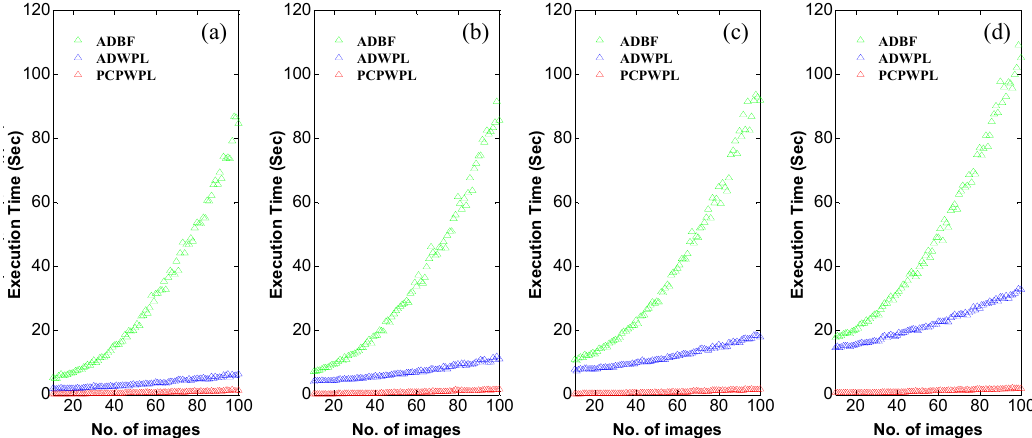
Figure 5. Execution time of the tested methods under different window size of ( a ) 7 × 7, ( b ) 11 × 11, ( c ) 15 × 15, and ( d ) 21 × 21.